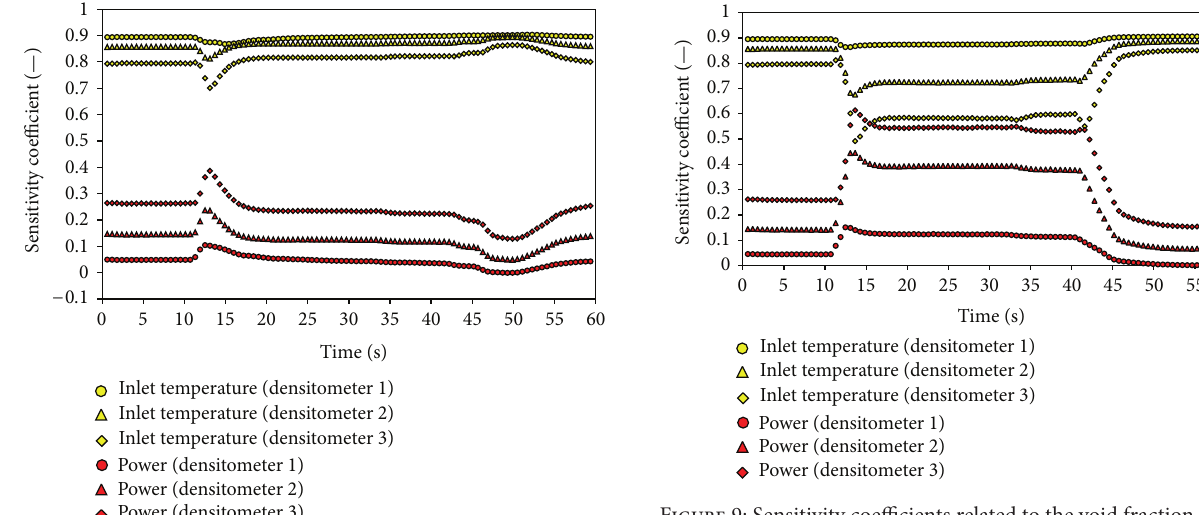
Figure 9: Sensitivity coefficients related to the void fraction during the recirculation pump trip at three axial elevations (TRACE-